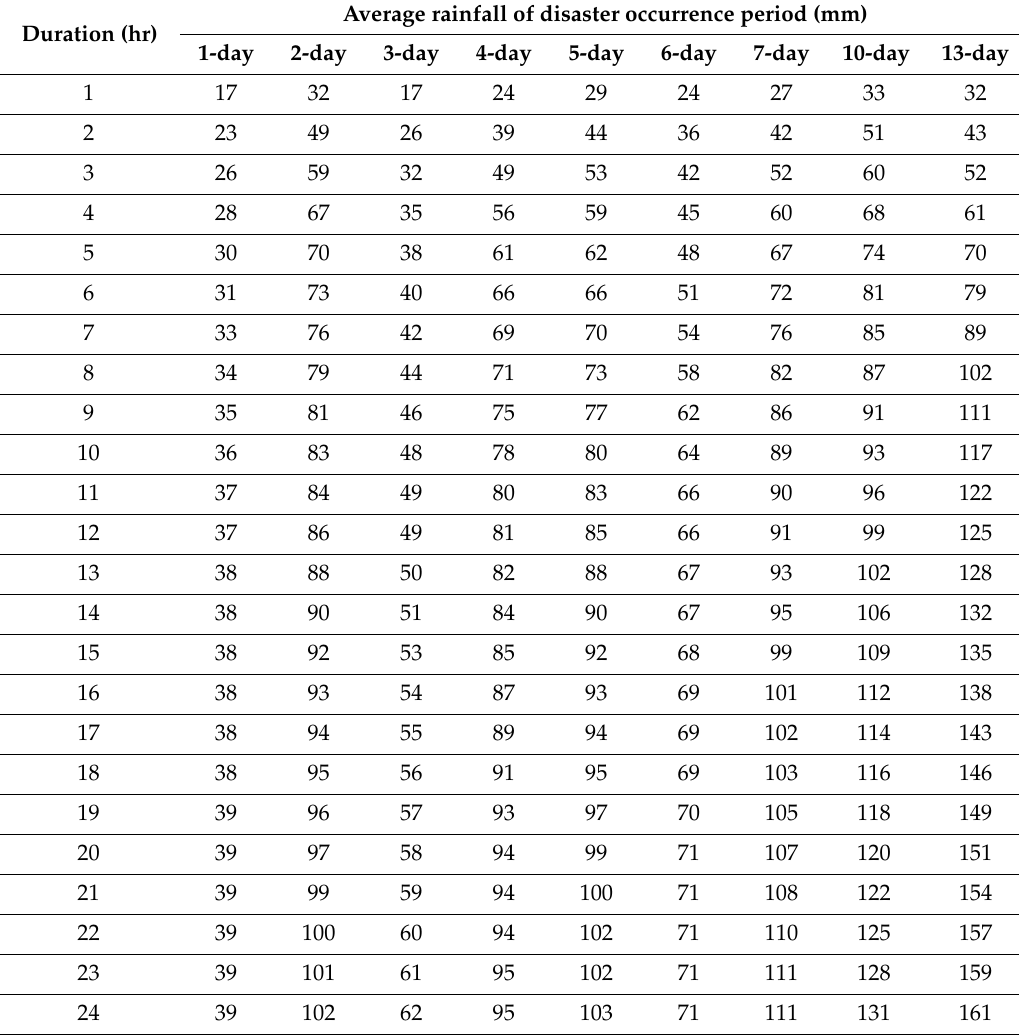
Table 5. Average rainfall by duration representing disaster occurrence